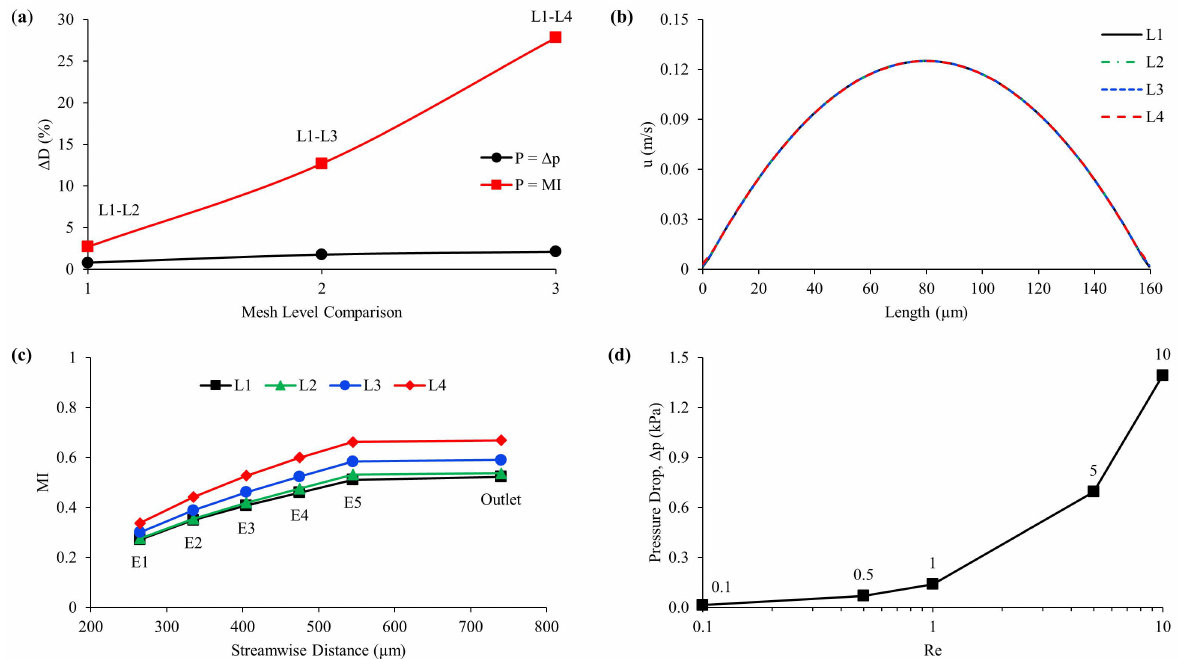
Figure A4. Mesh study outcomes and the change of pressure drop in the CSFO micromixer: ( a ) difference, as a percentage, between L1 and L2, L3, L4 mesh densities with respect to ∆ p and MI parameters; ( b ) velocity distribution on the diameter of outlet cross-section obtained from L1, L2, L3, and L4 mesh level solutions; ( c ) development of mixing efficiency along the CSFO micromixer in L1, L2, L3, and L4 mesh solutions. MI values are computed on E1, E2, E3, E4, and E5 cross-sections which are normal to the z-direction; ( d ) ∆ p vs. Re number in the CSFO